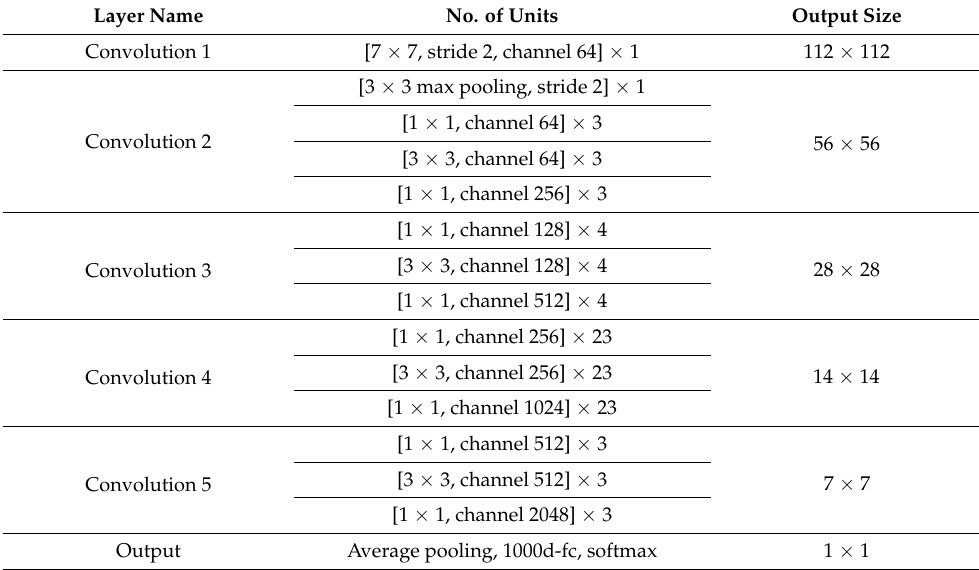
Table 2. ResNet-101 Architectures layer parameters